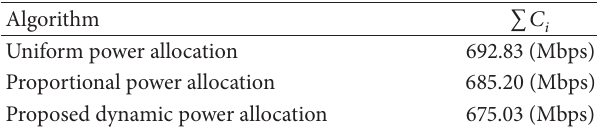
Figure 2: Distribution of the capacity allocated to each beam, for the three algorithms in Scenario 1. Table 1: Total system capacity of the three algorithms in Scenario 1.